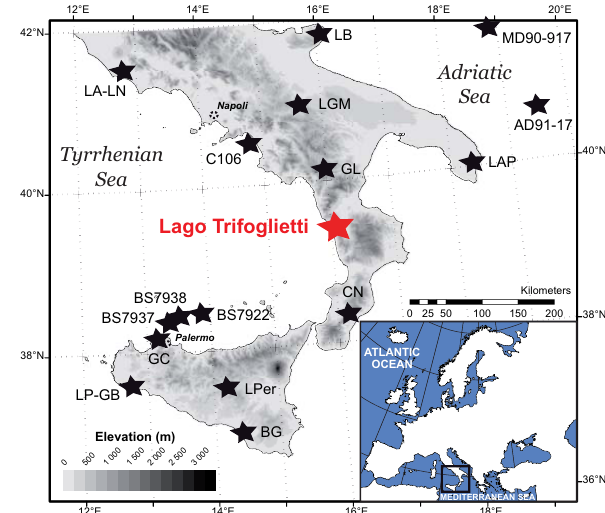
Fig. 1. Location of study site and other sites considered in the text: Lago Albano and Nemi (Ariztegui et al., 2000 and references therein), Lago Battaglia (Caroli and Caldara, 2007), Lago Alim- ini Piccolo (Di Rita and Magri, 2009), Lago Grande di Monticchio (Allen et al., 2002), C106 (Di Donato et al., 2008), Grotta di La- tronico (Colonese et al., 2010), Canolo Nuovo (Schneider, 1985), Lago di Pergusa (Sadori and Narcisi, 2001), Biviere di Gela (Noti et al., 2009), Grotta di Carburangeli (Frisia et al., 2006), Gorgo Basso (Tinner et al., 2009), Lago Preola (Magny et al., 2011b; Cal`o et al., 2012), AD91-17 (Sangiorgi et al., 2003), BS7938 (Sbaffi et al., 2004), MD90-917 (Siani et al.,